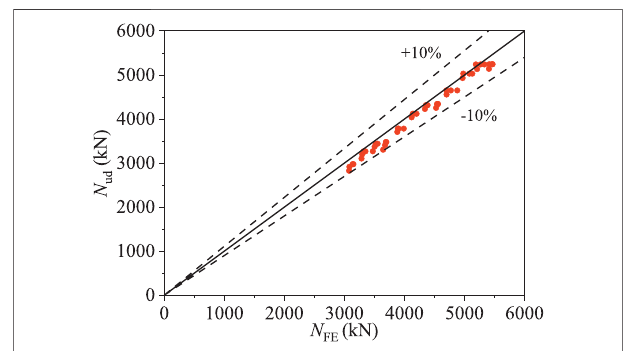
FIGURE 15 | Comparison of ultimate load between calculated results and FE results.